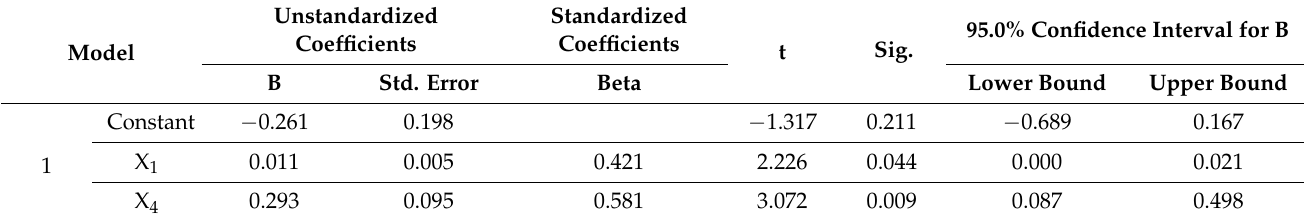
Table 13. Coefficients with two predictors.